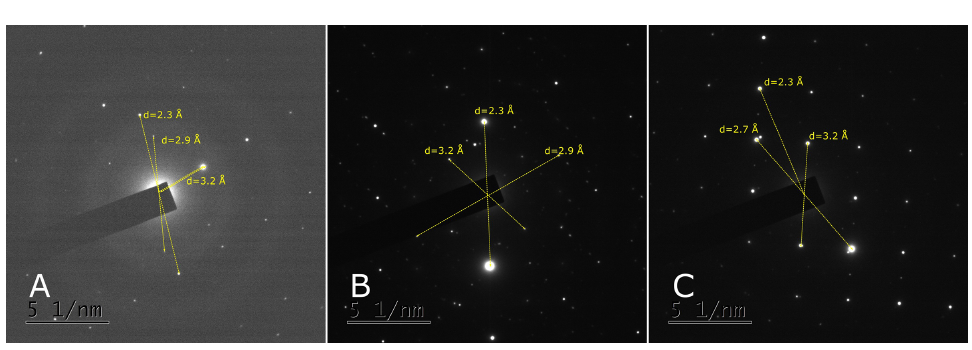
Figure 2 SAED pattern of BTO samples (A), (B) and (C) show the variation in crystallinity increasing with the addition of PEG-6000 during the synthesis. 2C shows the <117> plane of 2.7 Å spacing gaining prominenece with single crystallite-like features. The crystal planes measured on the SAED planes match those of bismuth titanate; a = 2.3 Å, b = 2.9 Å and c = 3.2